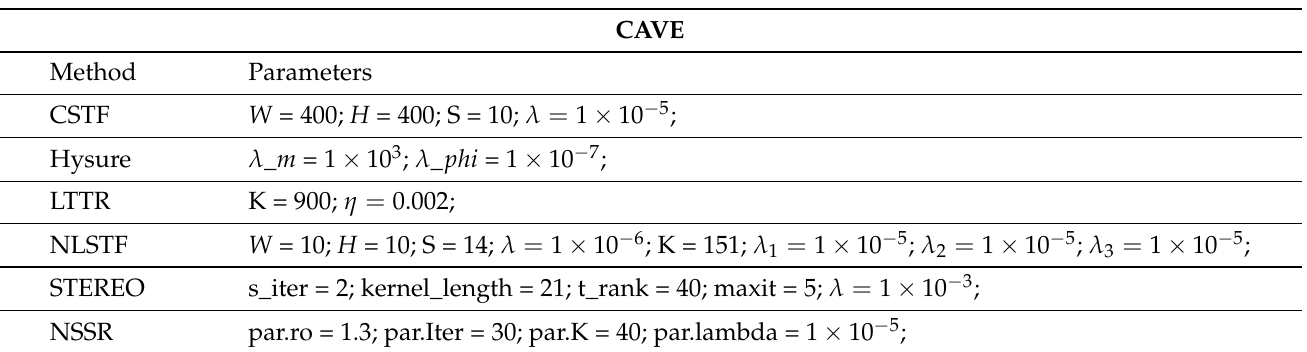
Table 2. Parameter settings on the CAVE